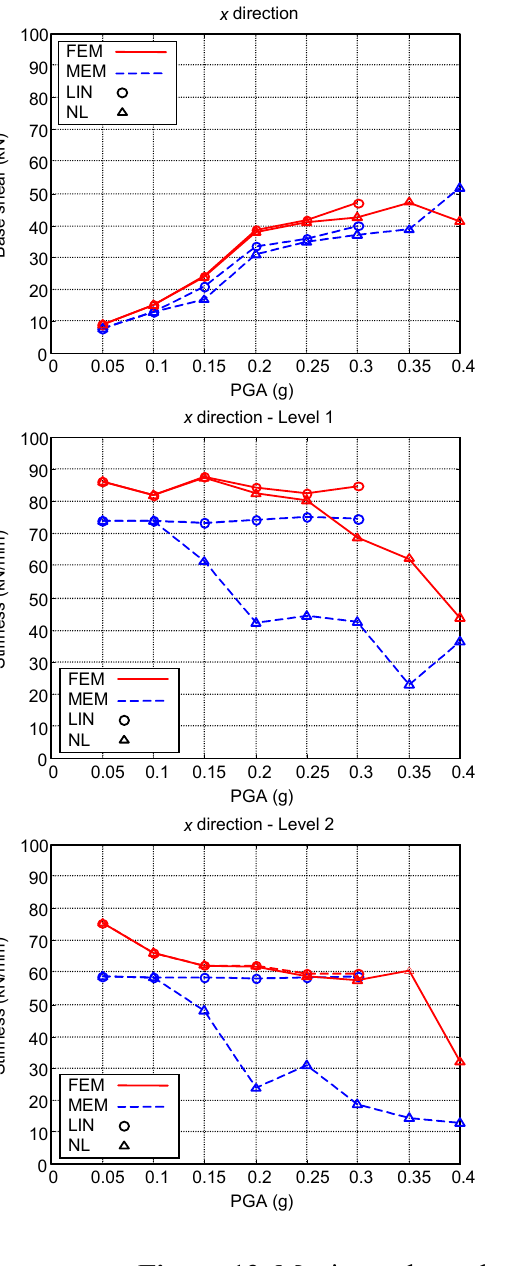
Figure 13. Maximum base shears and secant stiffness vs.